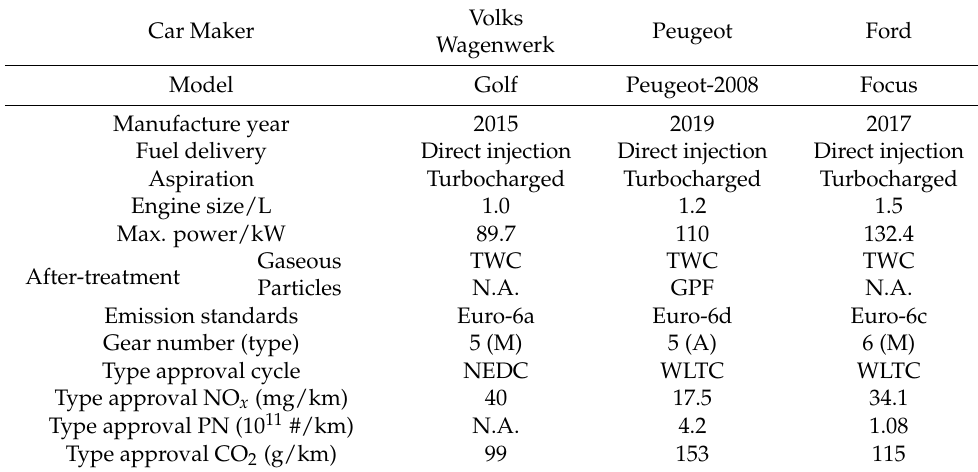
Table 1. Specifications of the three GDI vehicles.